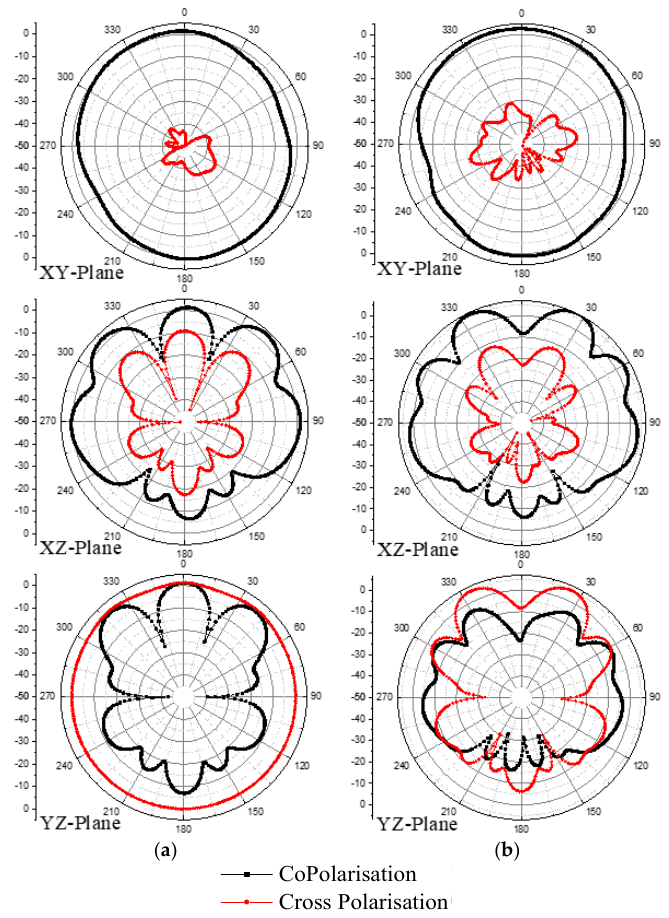
Figure 11. Normalized radiation pattern at: ( a ) 1.8 and ( b ) 2.4 GHz.